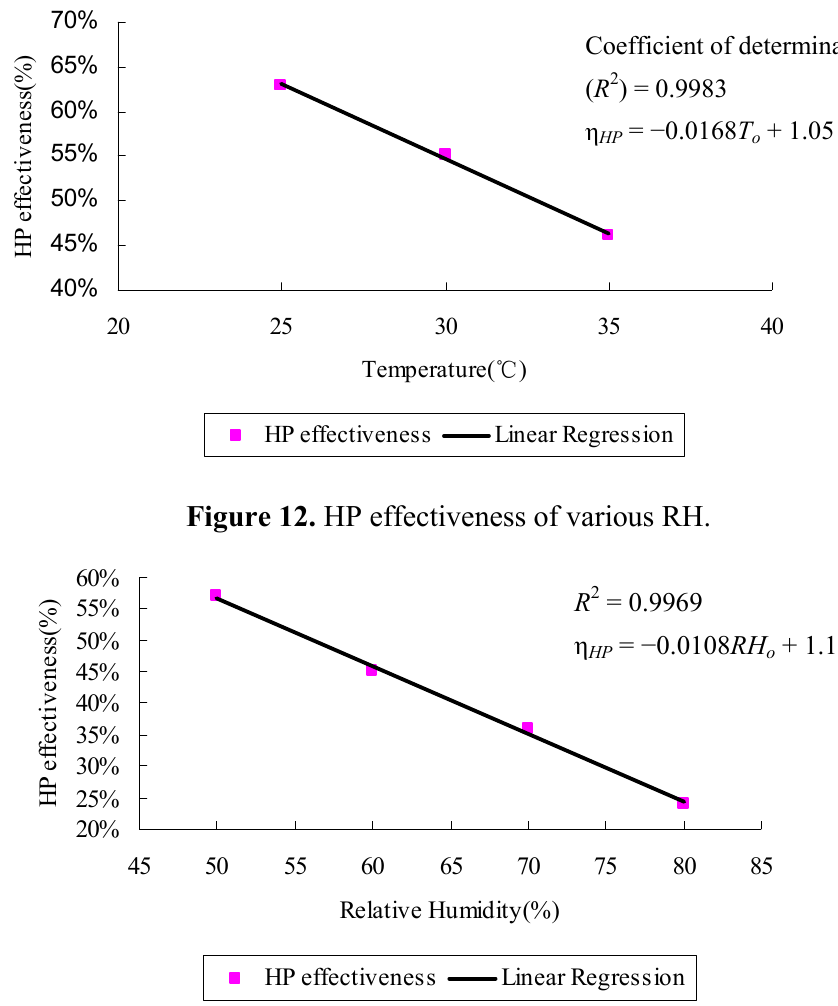
Figure 11. HP effectiveness of various temperature.